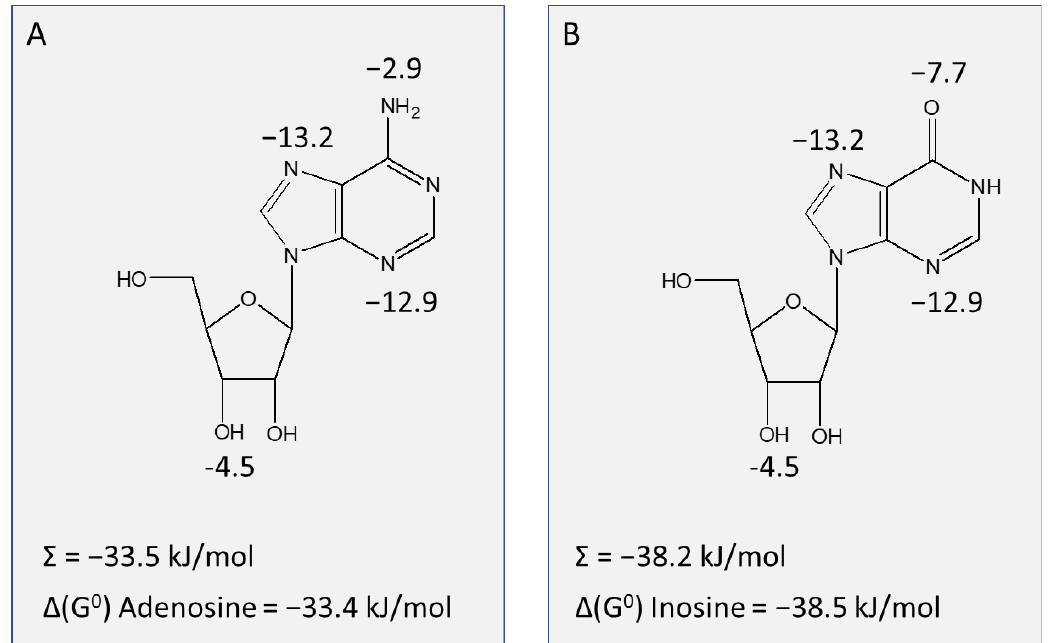
Figure 6. Binding model for TvxNT3 showing points of interaction in adenosine ( A ) and inosine ( B ), with the Gibbs free energy of the interaction indicated in kJ/mol. The sum of the interactions and the experimental interaction energies are also indicated. Table 4. K i for purines on the transport of [ 3 H]-adenosine by TvxNT3.